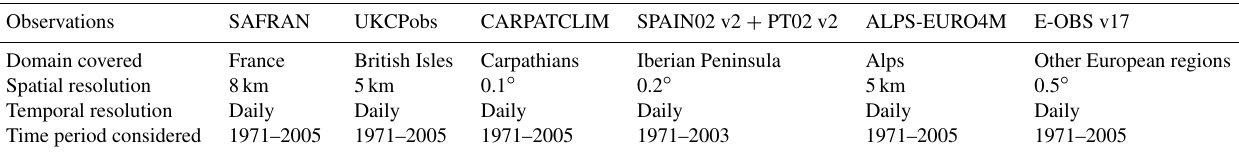
Table 3. Information about the observational datasets used in this study (refer to Fig. S1 for the coverage). The time period refers to that considered in this study, not the available period of each observational